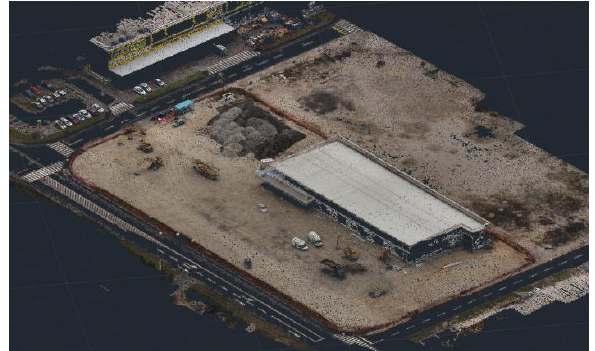
Figure 3. Point cloud representation of construction site